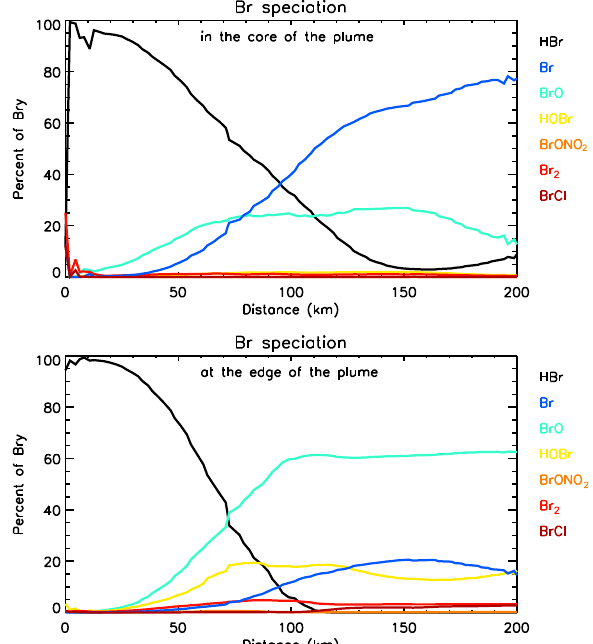
Figure 7. Br speciation along the plume (in the core and at the edge) in the simulation S1 and the 2km × 2km grid for the 12 January 2005 at 06:00UTC. The Br speciation has been cal- culated as the percent of Br y (Br y = HBr + 2Br 2 + BrCl + Br + BrO + HOBr + BrONO 2 ) . Distance is calculated from the middle of the grid box containing Marum and Benbow.